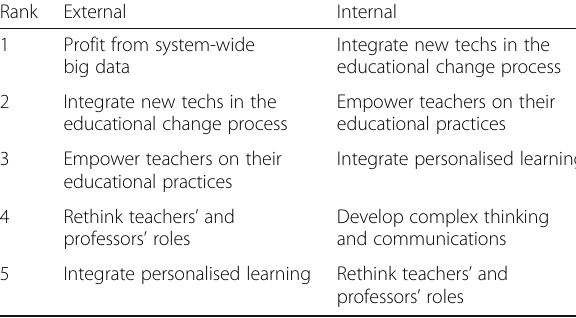
Table 4 Top 5 implementation